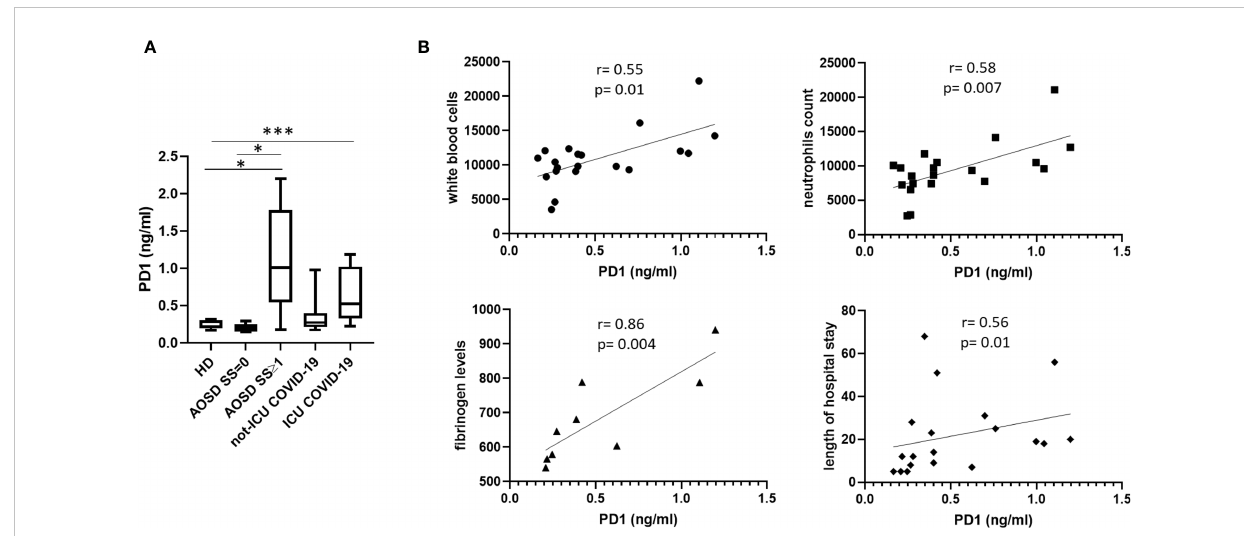
FIGURE 2 Levels of protectin D1 in HDs, COVID-19 and AOSD patients. (A) . Plasma levels of PD1 (ng/ml) in HDs (n=13) and patients affected by COVID-19 (not-ICU COVID-19, n= 11; ICU COVID-19, n=10) and AOSD (n=13) patients. Data are represented as box plots displaying medians, 25th and 75th percentiles as boxes, and 10th and 90th percentiles as whiskers. HD vs AOSD SS ≥ 1, *p= 0.04; AOSD SS=0 vs AOSD SS ≥ 1, *p=0.02; HD vs ICU COVID-19, p= 0.0006; not-ICU COVID-19 vs ICU COVID-19, *p= 0.02, *** p < 0.0001 (B) Correlation analysis between PD1 levels and white blood